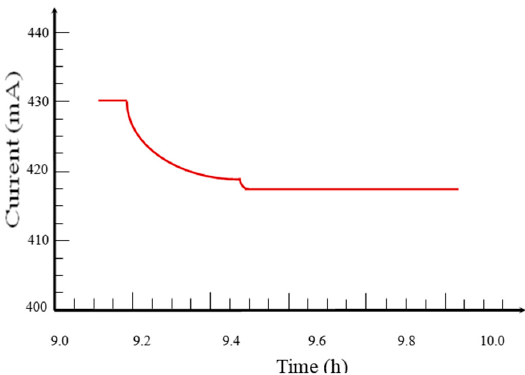
Figure 12. Current consumption as a function of the variation of time.